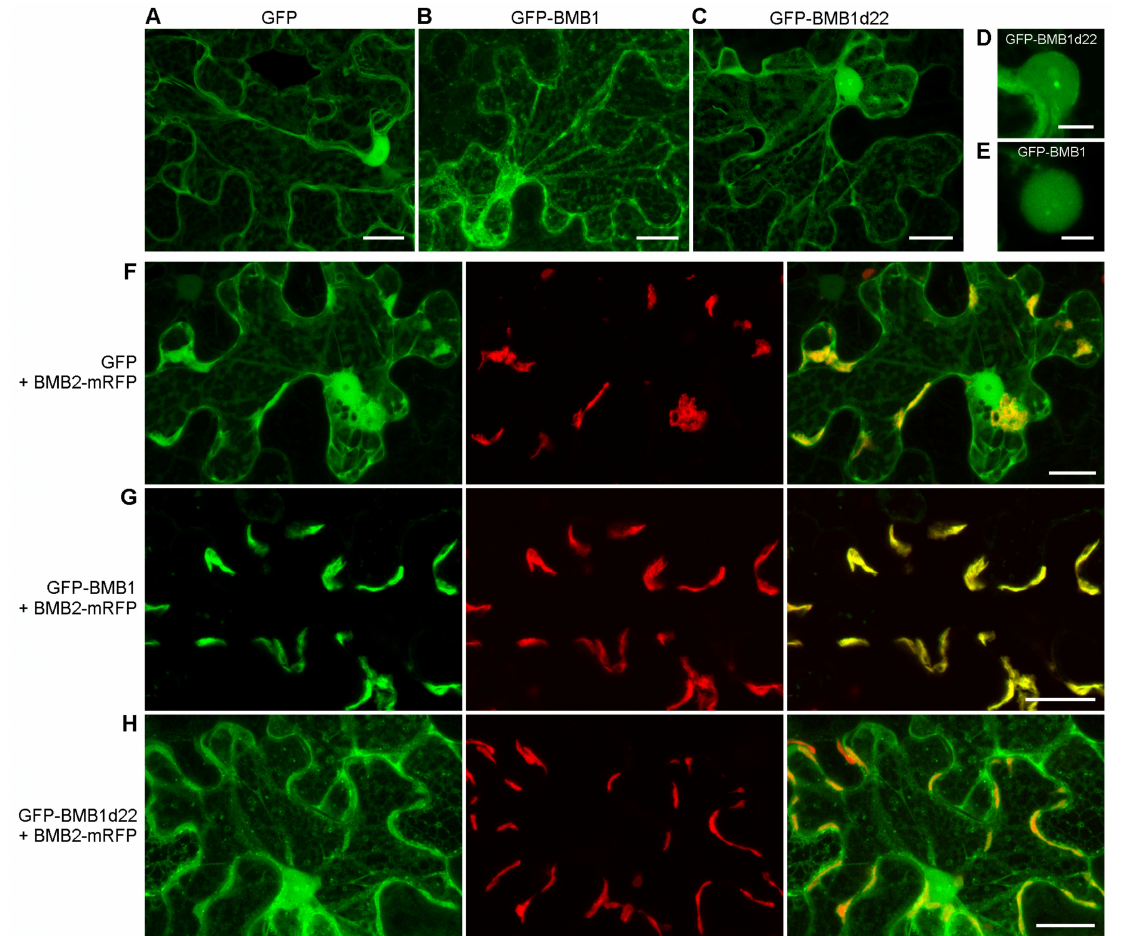
Figure 2. Subcellular localization of GFP-BMB1d22 in comparison to those of GFP and GFP-BMB1. Top line, localization of GFP ( A ), GFP-BMB1 ( B ), GFP-BMB1d22 ( C ) and higher magnification images of nuclei in cells expressing GFP-BMB1d22 ( D ) and GFP-BMB1 ( E ). ( F ), coexpression of GFP and BMB2-mRFP. ( G ), coexpression of GFP-BMB1 and BMB2-mRFP. ( H ), coexpression of GFP-BMB1d22 and BMB2-mRFP. In F-G, left images represent GFP channel, center images—mRFP channel, right images—superposition of images for GFP and mRFP channels. All images are reconstructed from Z-series of optical sections. Scale bar, 20 µ m ( A – C , F – H ) and 5 µ m ( D , E